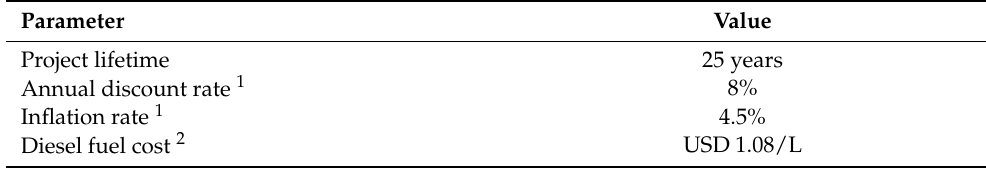
Table 7. Project economic input assumptions.